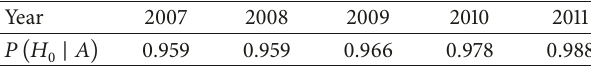
Table 2: The credibility of prior